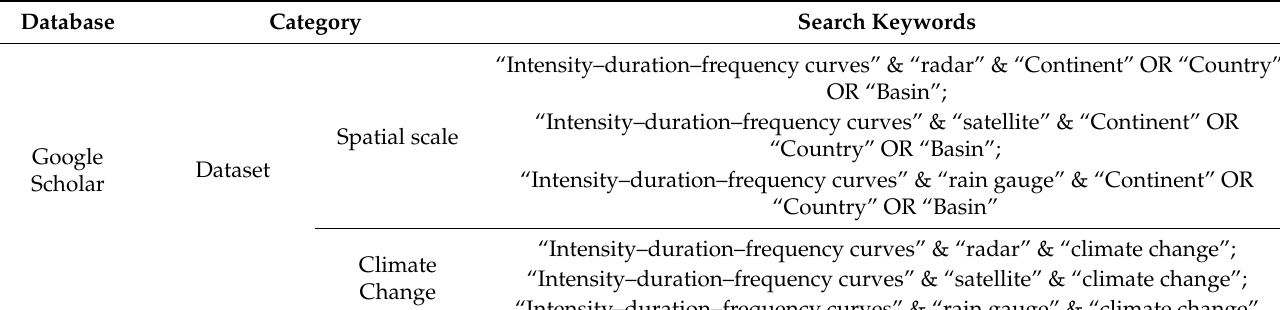
Table 1. Search procedure used to identify relevant